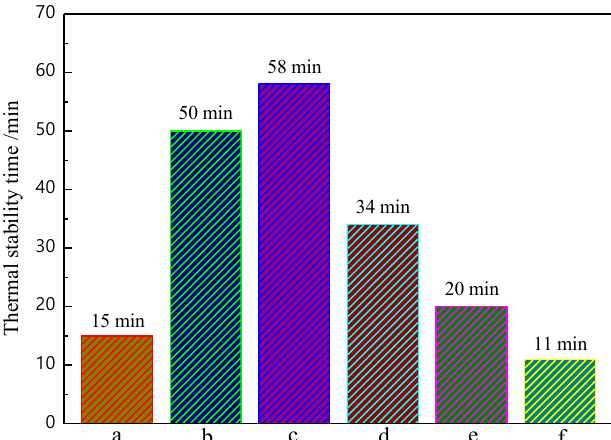
Figure 5. Thermal stability time of pure PVC and PVC stabilized by MSE-Al / ZnSt 2 at the content of 4 phr in 180 ◦ C. a, pure PVC; b, 4 phr MSE-Al; c, 3 phr MSE-Al + 1 phr ZnSt 2 ; d, 2 phr MSE-Al + 2 phr